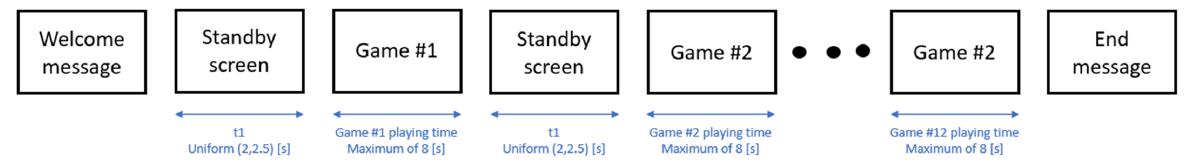
Figure 2. Experimental paradigm with timeline.